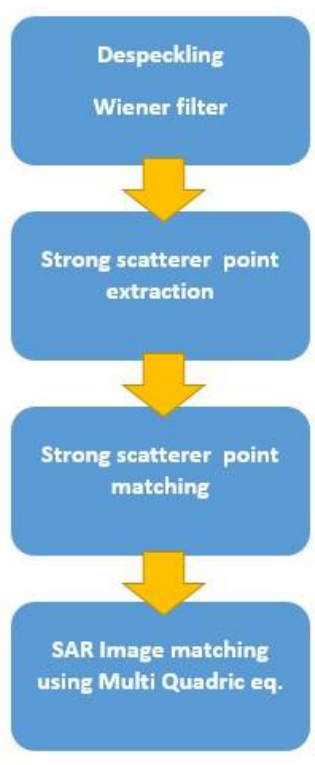
Figure 1. General workflow of proposed method